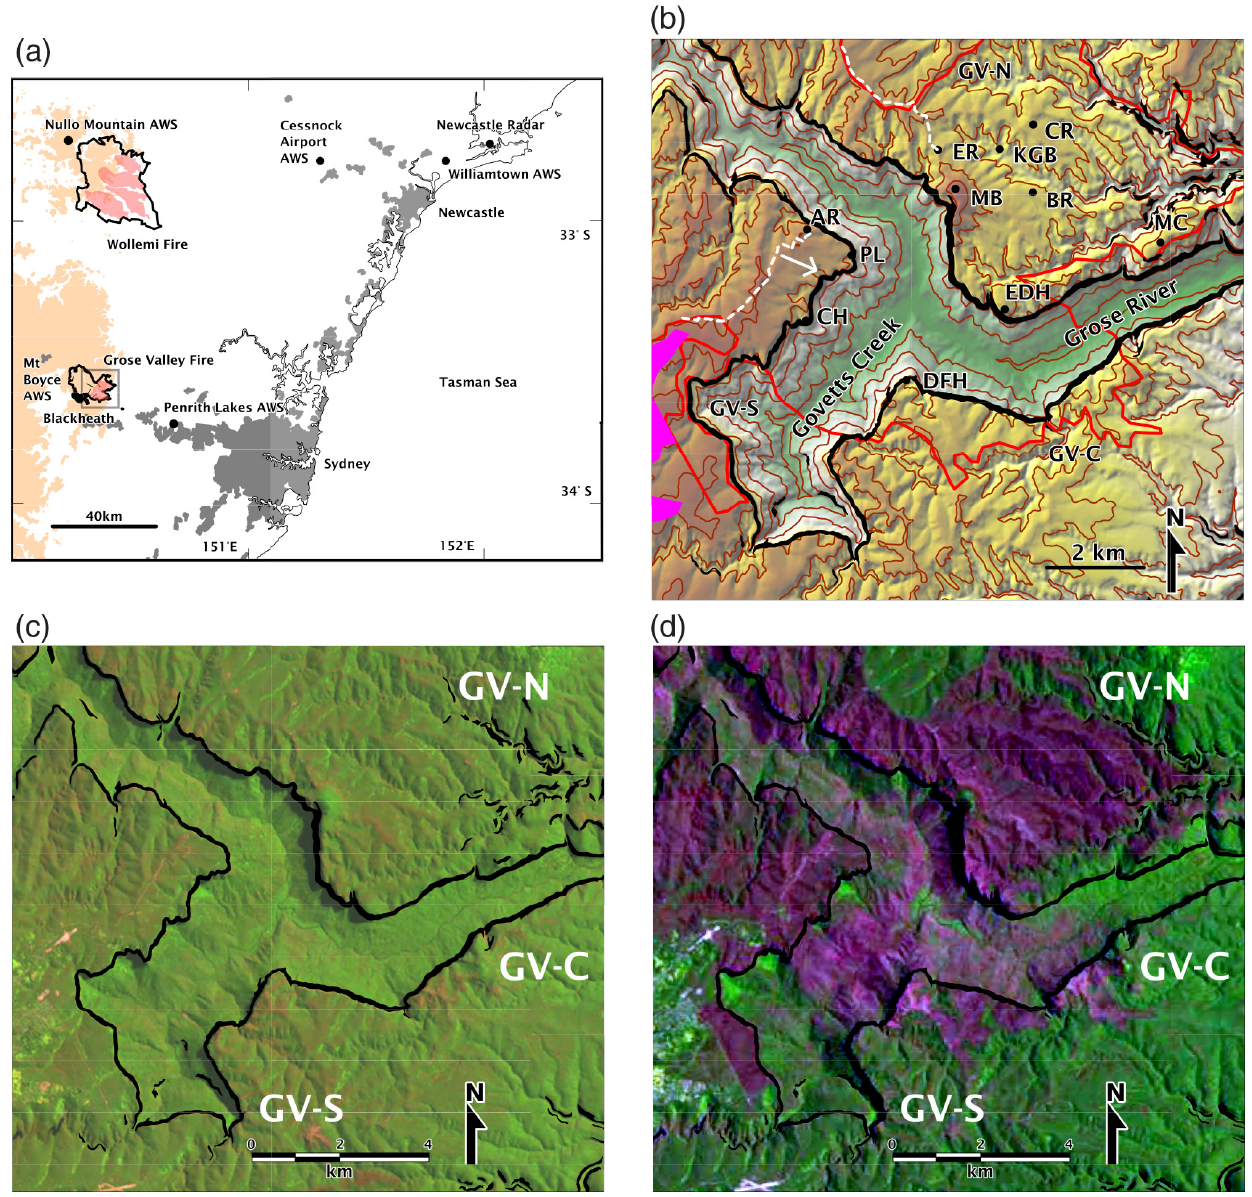
Figure 1. (a) Location map, showing: urban areas (grey), areas above 800ma.s.l. (orange), burnt areas (black outline) and blow-up fire events (red). Also shown is the extent of the other figure panels. (b) Localities for the Grose Valley fire: the outskirts of the town of Blackheath (lower left) are shown in magenta, while the final fire area is outlined in red. The contour interval is 100m, major cliff lines are shown by heavy black lines. Elevation colours: 300m is green; 600m is white; 800m is yellow; 1100m is brown. The three fire areas are labelled GV- N, GV-C and GV-S. Locality codes are: AR – Anvil Rock; BR – Banks Ridge; CH – Clarke Head; CR – Carmarthen Ridge; DFH – Du Faur Head; EDH – Edgeworth David Head; ER – Explorers Range; KGB – King Georges Brook; MB – Mt Banks; MC – Mt Caley; PL – Perrys Lookdown. The white dashed lines are the easterly containment lines early on 22 November. (c) Landsat imagery from 2002. (d) Landsat imagery from 5 weeks after the Grose Valley fire. The intensity of the red is a measure of fire intensity (Landsat 5 Thematic Mapper, Path 9 Row 83, 27 December 2006). Major cliff lines are highlighted in (b) , (c) and (d)